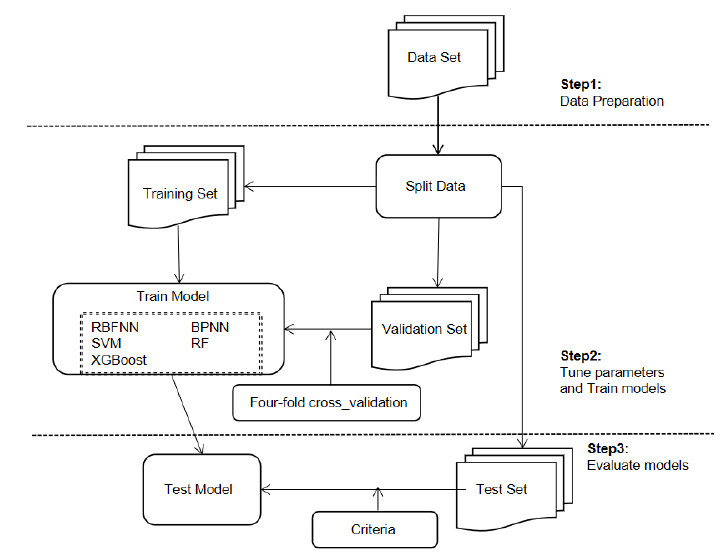
Figure 7. The training process of prediction models.